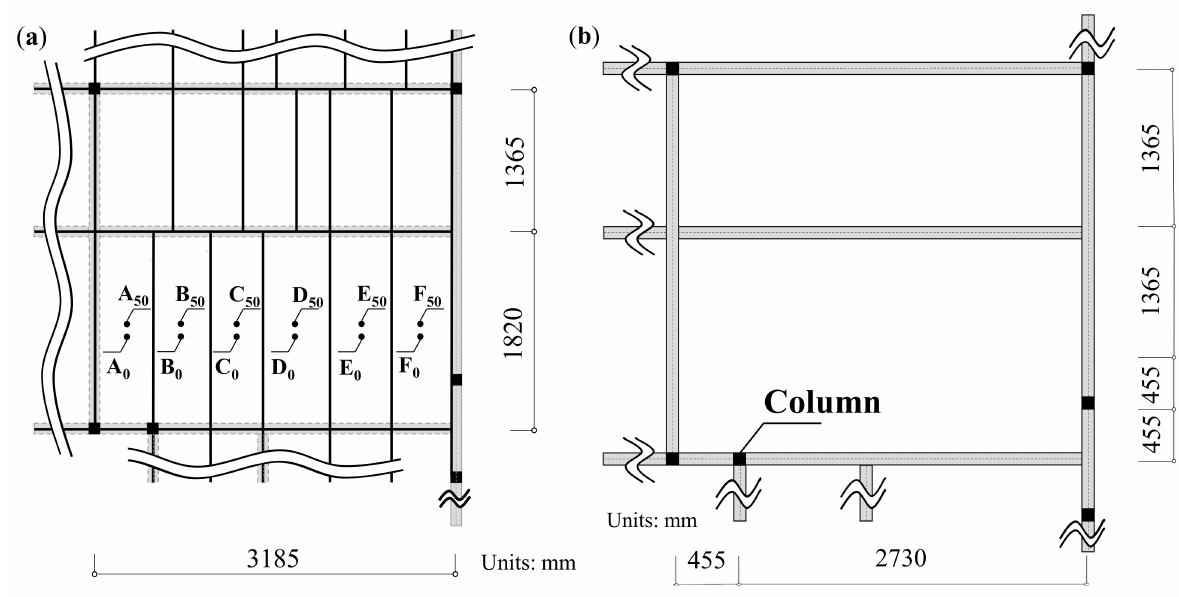
Figure 1. ( a ) Setup of ALC panels and arrangement of vibration receiving and source points; ( b ) beam plan of steel-frame